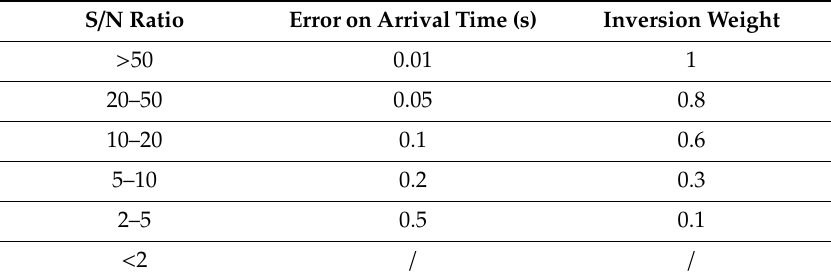
Table 3. Conversion table from the signal to noise ratio to the measurement uncertainties on the arrival times and inversion weights. The symbol “ / ” indicates that the correspondent data are not